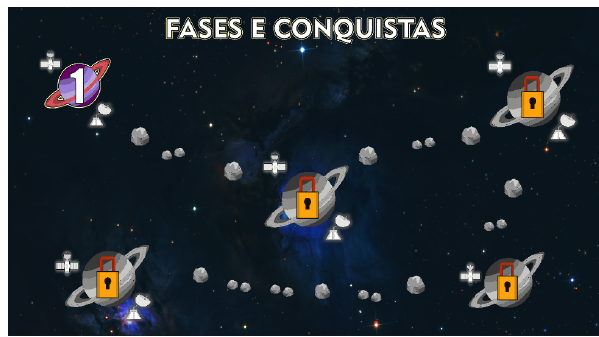
Figure 3. Levels and achievements